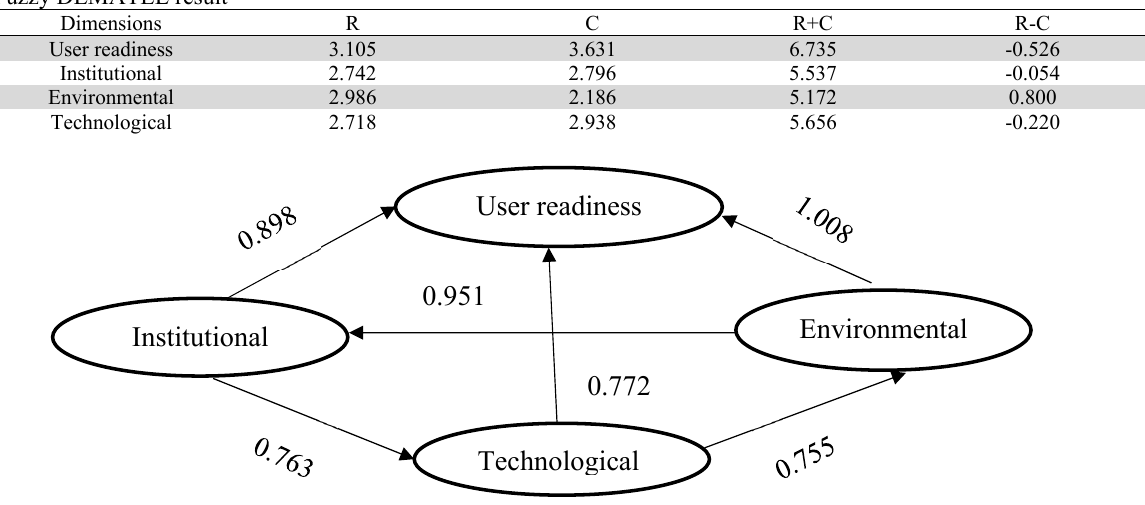
Fig. 3. The interactions graph among four dimensions